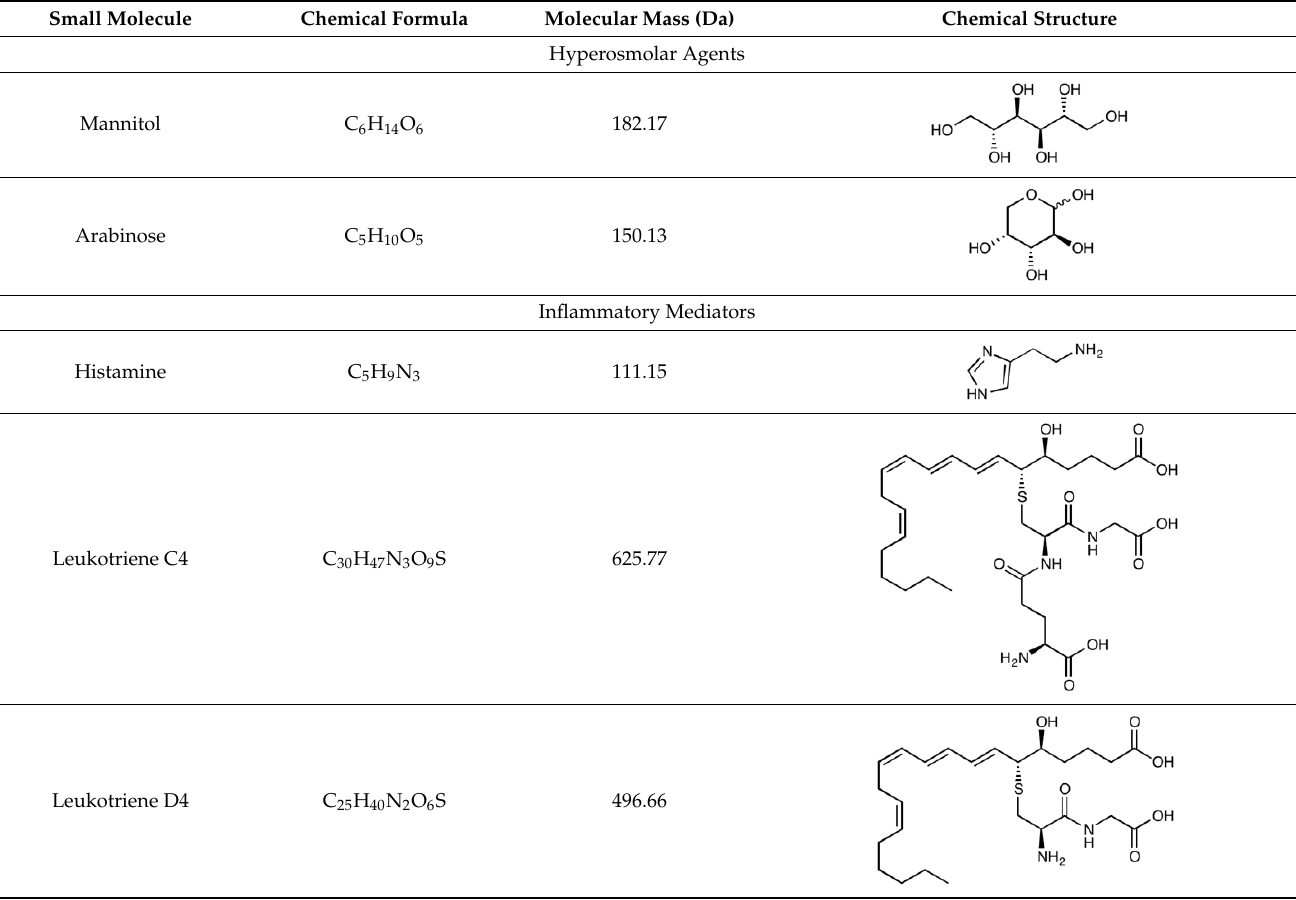
Table 4. Chemical Properties of BBB modulators.